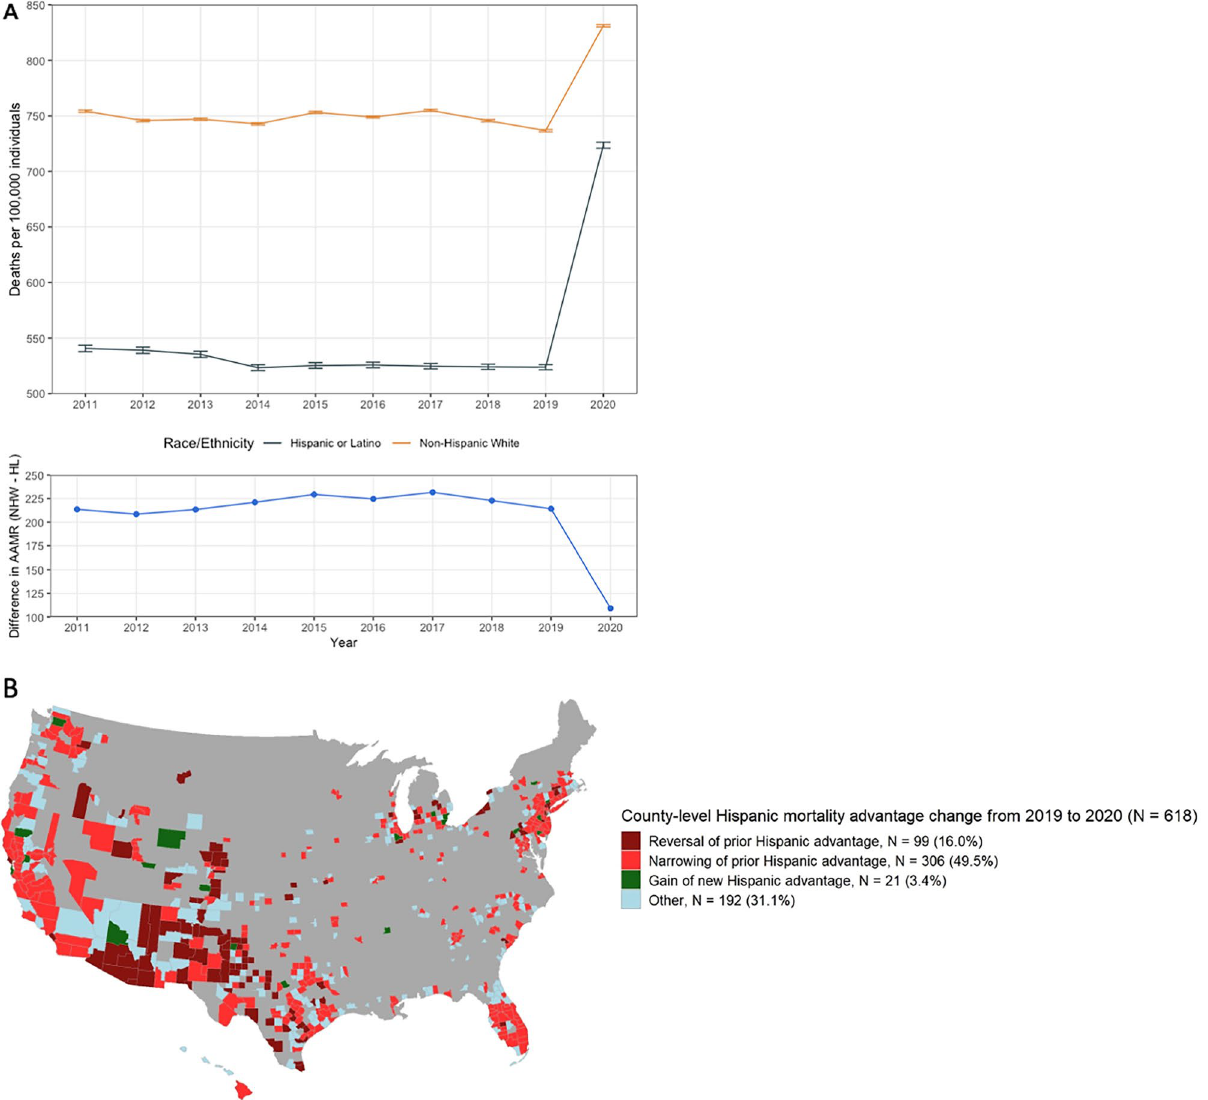
Figure 1. ( A ) National trends in Hispanic and NHW AAMRs in the US, 2011–2020. The first graph shows the individual Hispanic and NHW AAMRs (deaths per 100,000 individuals) and 95% confidence intervals by year. The second graph shows trends in the absolute national Hispanic mortality advantage (deaths per 100,000 individuals) by year when defined as the average NHW AAMR minus the average Hispanic AAMR.